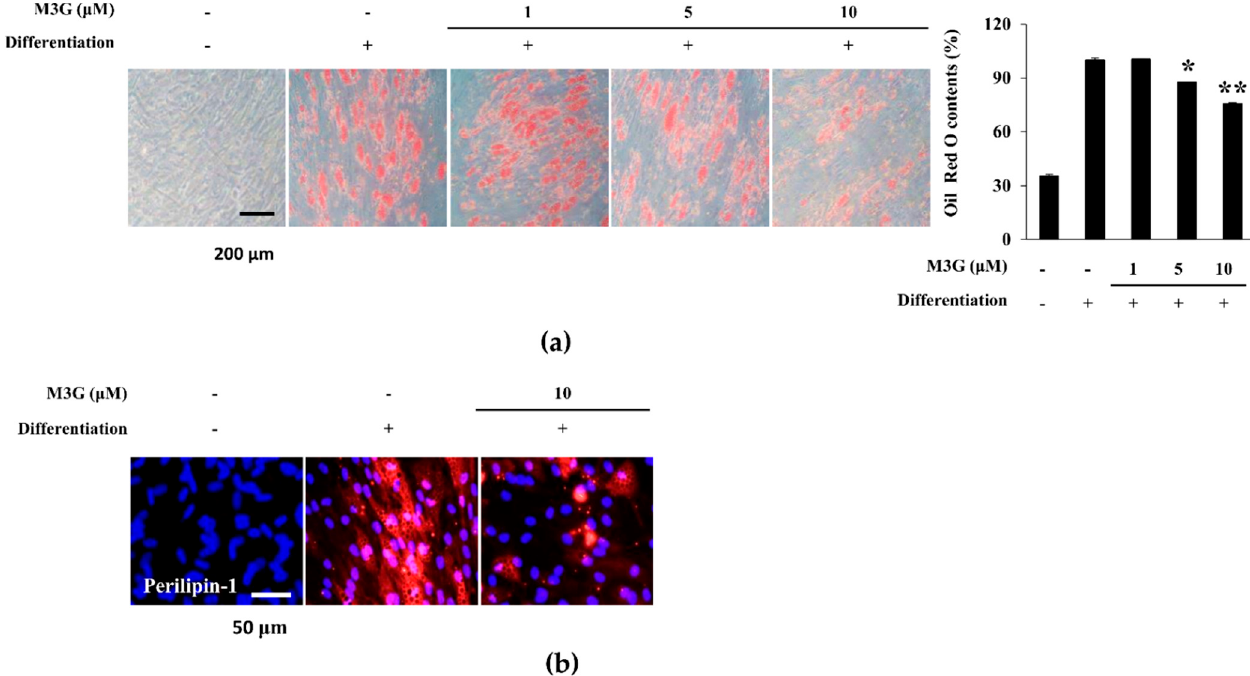
Figure 6. Effect of M3G on adipogenic differentiation of hBM-MSCs. ( a ) Effect of M3G on the intracellular lipid accumulation in adipo-induced hBM-MSCs at day 10 of differentiation. Lipid droplets were stained with Oil Red O and the quantification was carried out by measuring absorbance values of retained dye. Lipid accumulation level was given as relative percentage of Oil Red O dye compared to adipo-induced untreated group. * p < 0.05, ** p < 0.01 vs. differentiated untreated group. ( b ) Effect of M3G on the expression of perilipin-1 in adipo-induced hBM-MSCs at day 10 differentiation analyzed by immunofluorescence staining. DAPI staining was used to highlight the nucleus of viable cells. Scale bar: 50 µ m. M3G was treated with initial differentiation induction (3 days) and was not present in subsequent media changes.